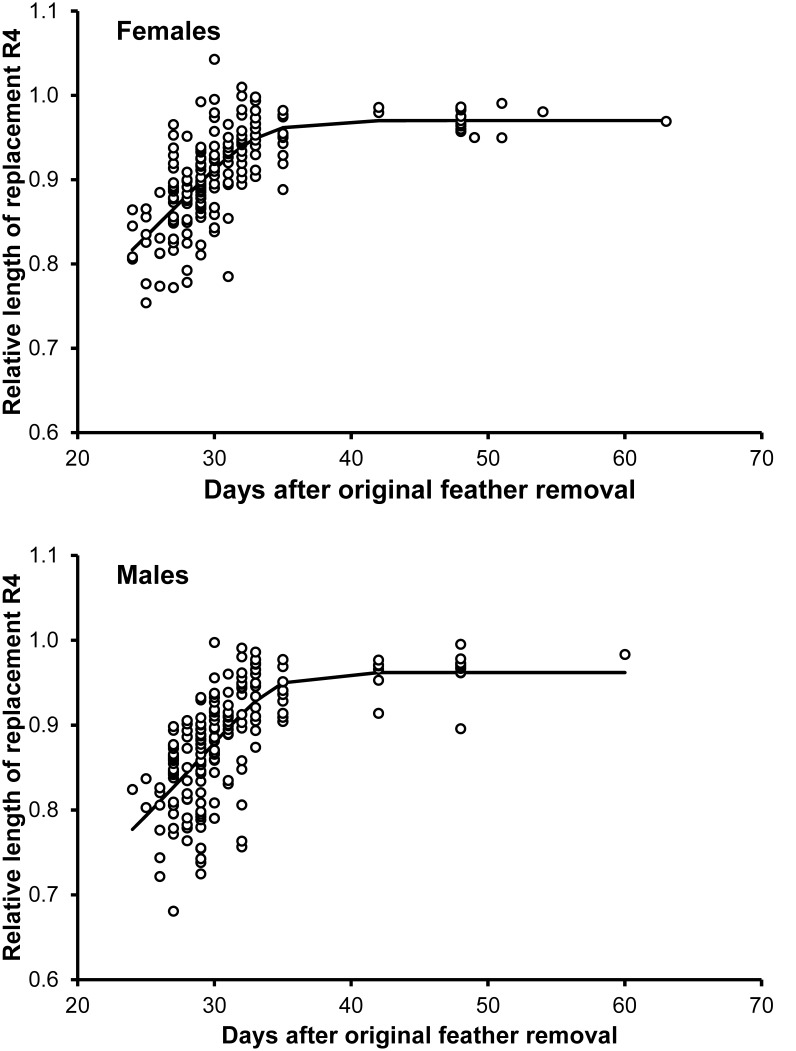
Length of the growing R4 in relation to time since feather removal.Length of the growing R4 relative to the length of the original R4 in relation to time since removal of the original R4. The continuous lines represent the Gompertz functions fitted to the data.